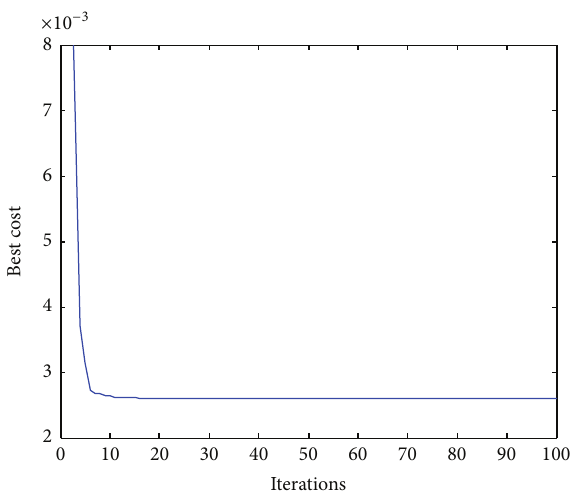
Figure 7: Convergence diagram of